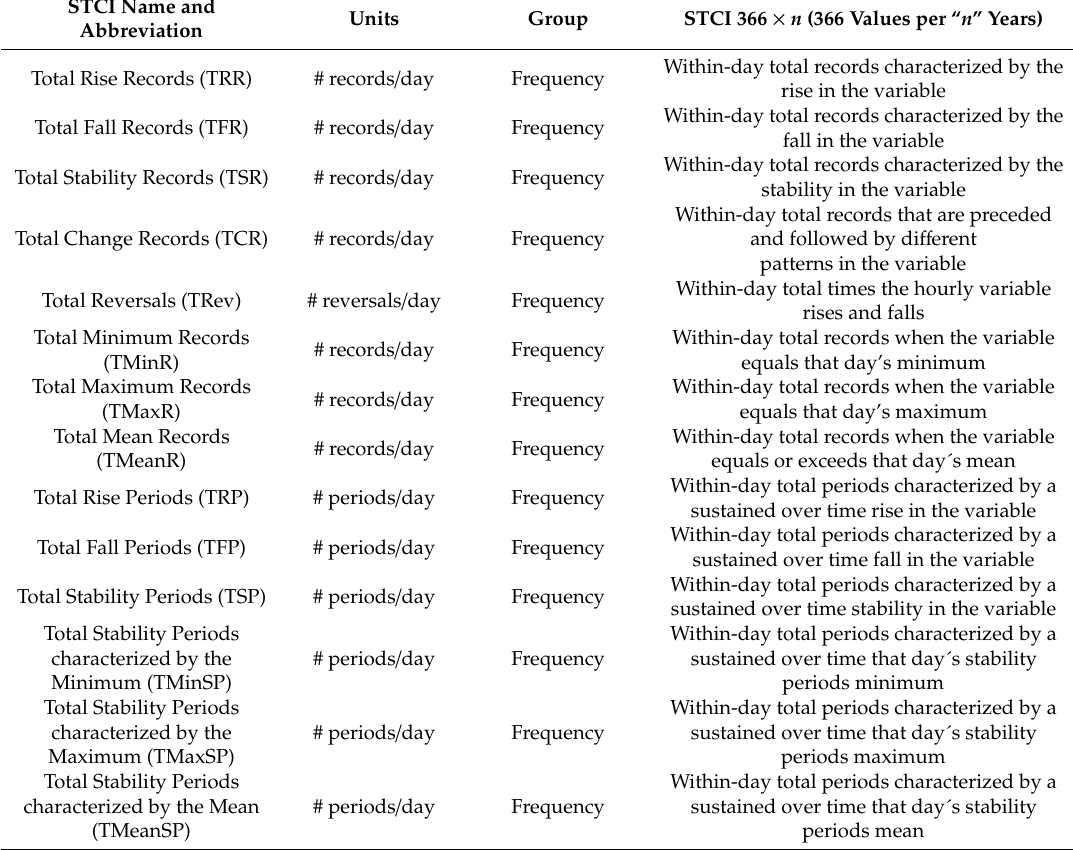
Table 2. Short-term characterization indicators calculated in indicators of short-term hydrological alteration (InSTHAn). # means “number